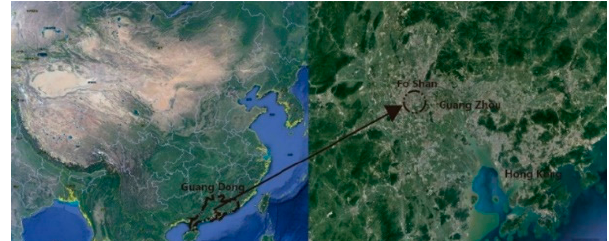
Figure 2. Introduction to Fo Shan.